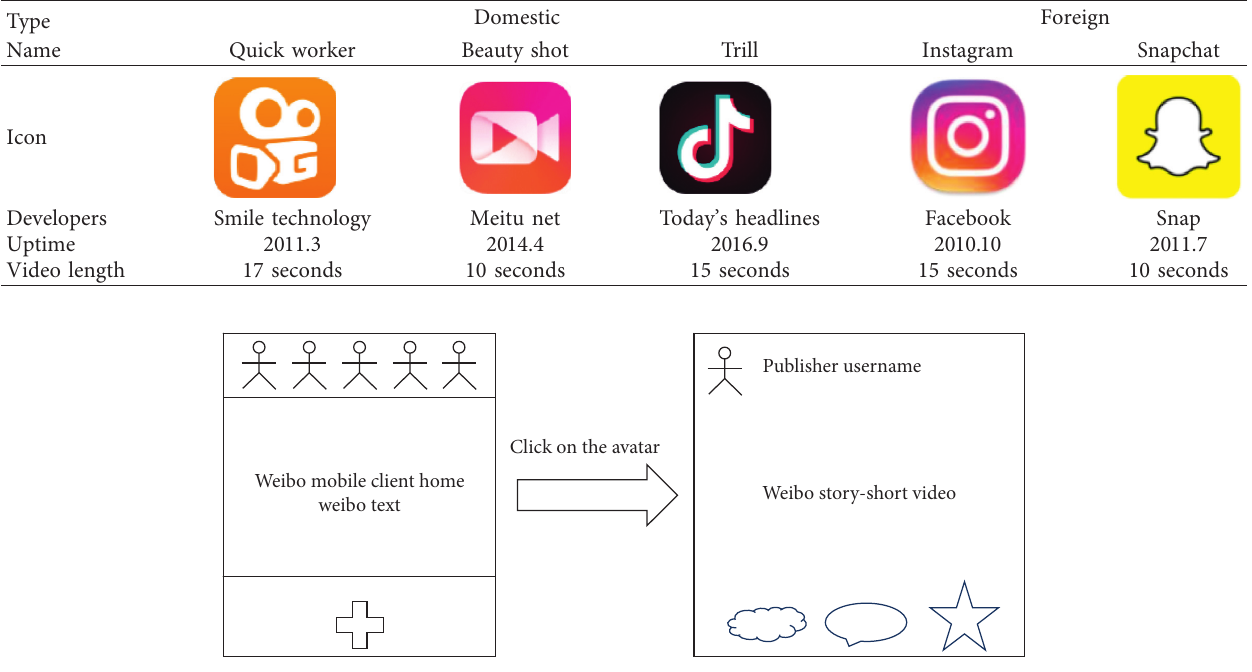
Figure 2: Interface diagram of microblog mobile phone client.